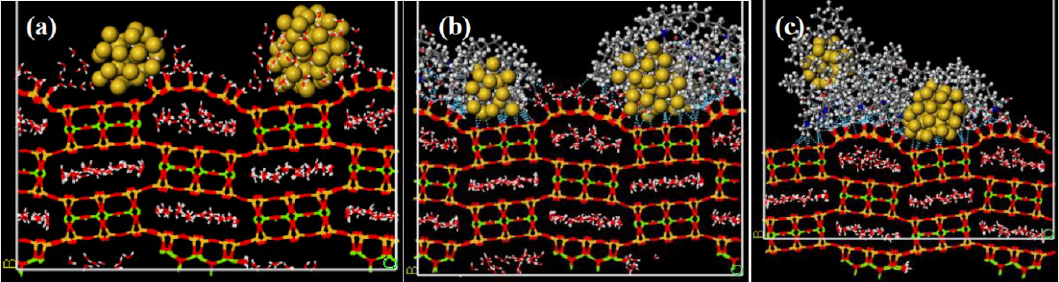
Figure 11. Side views of the final structures for the AuNPs/SEP ( a ), monolayer AuNPs/SEP ( b ), and bilayer AuNPs/SEP ( c ) models, respectively 1.25 ns later.